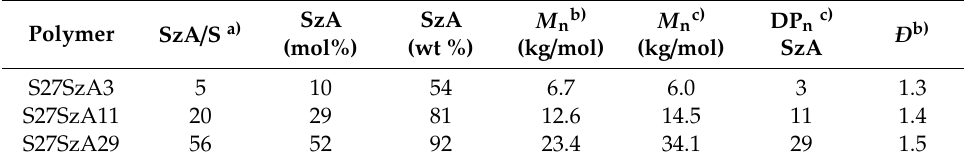
Table1. Experimentalconditionsforthesynthesisandphysical-chemicalpropertiesofblockcopolymers.